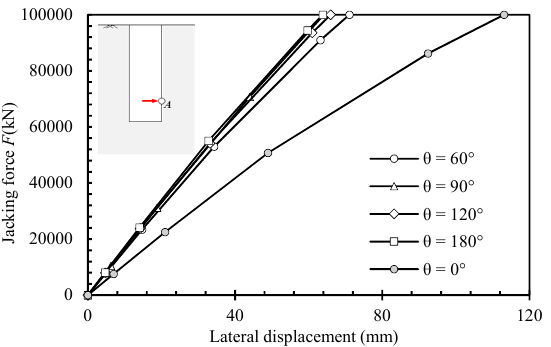
Figure 13. The load–lateral displacement curve of a caisson with different reinforcement angles.